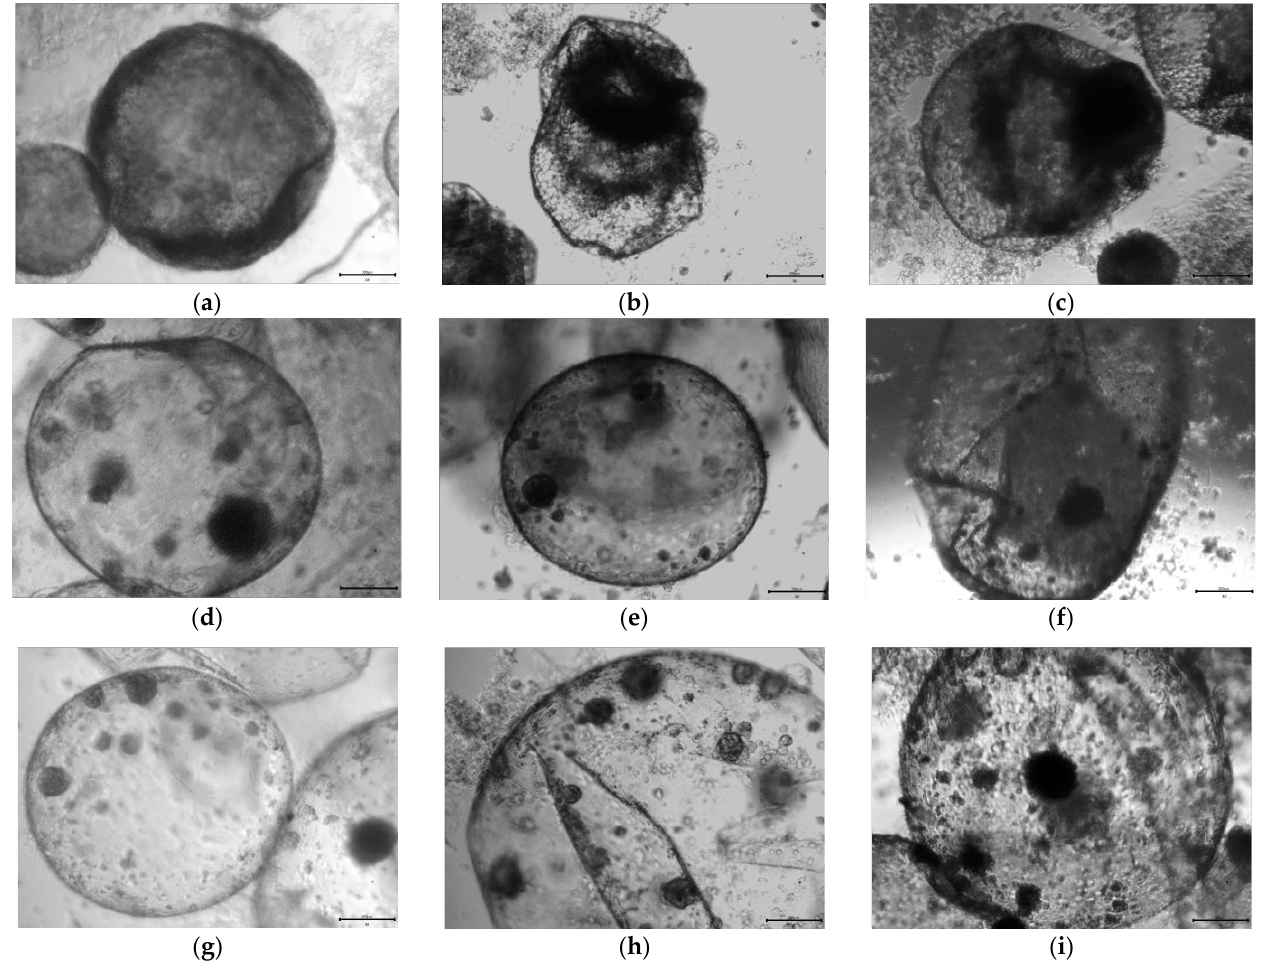
Figure 11. Brightfield microscopy images of the 90-day encapsulation culture. ( a – c ) Chondrocyte days 30, 60, and 90; ( d – f ) bMSC days 30, 60 and 90; ( g – i ) mixed days 30, 60, and 90.